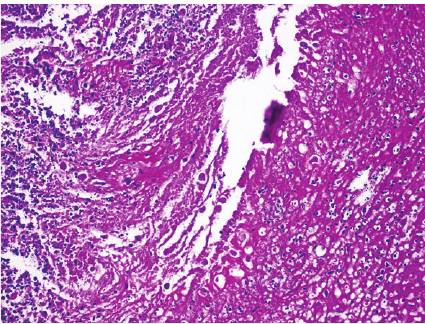
Figure 4: Microscopic appearance of Entamoeba trophozoites on the surface of necrotic tissue (H.E. ×